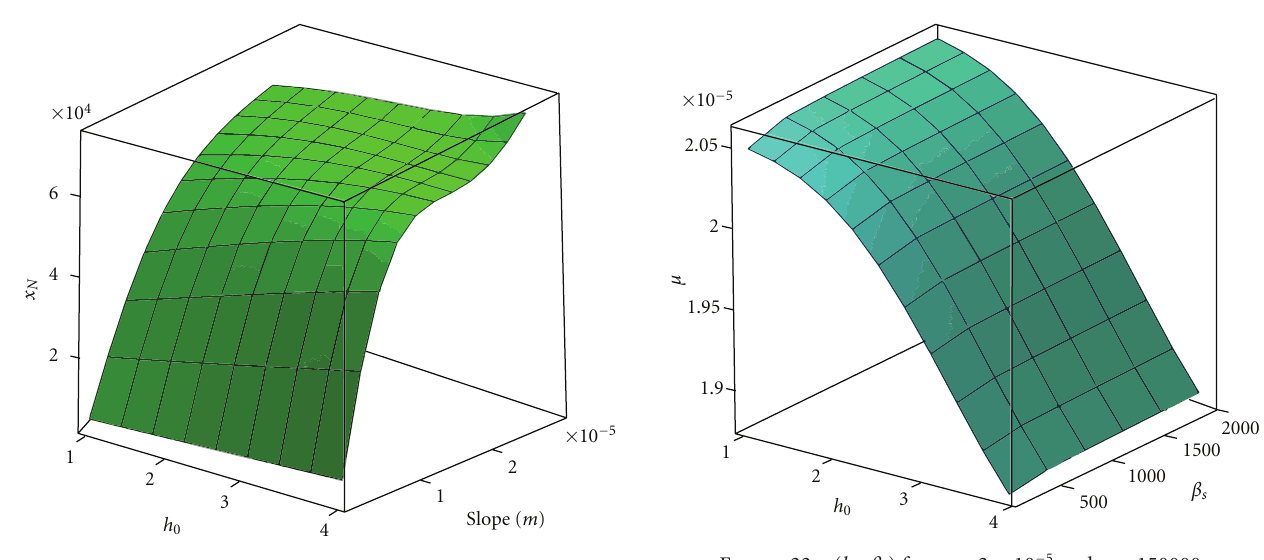
Figure 20: x N ( h 0 , m ) for β s = 500 and a = 150000.